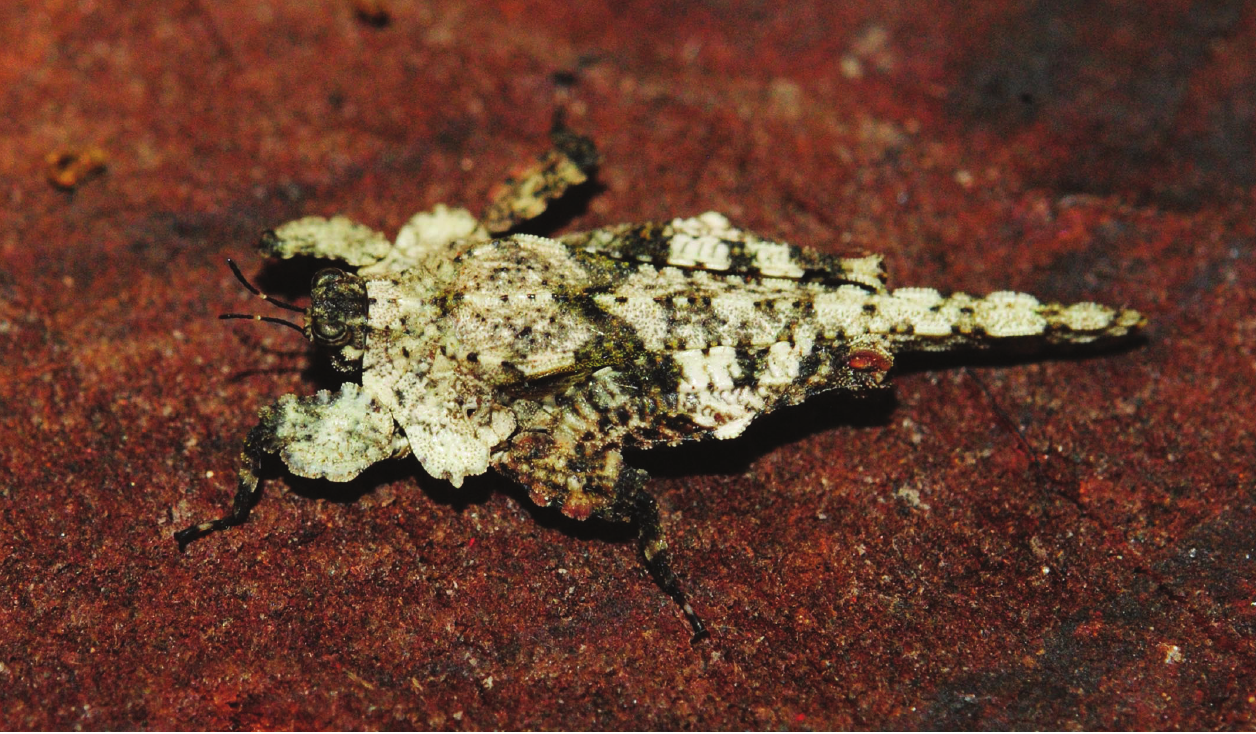
Fig. 3. Live Amorphopus notabilis from Brazilian Amazon